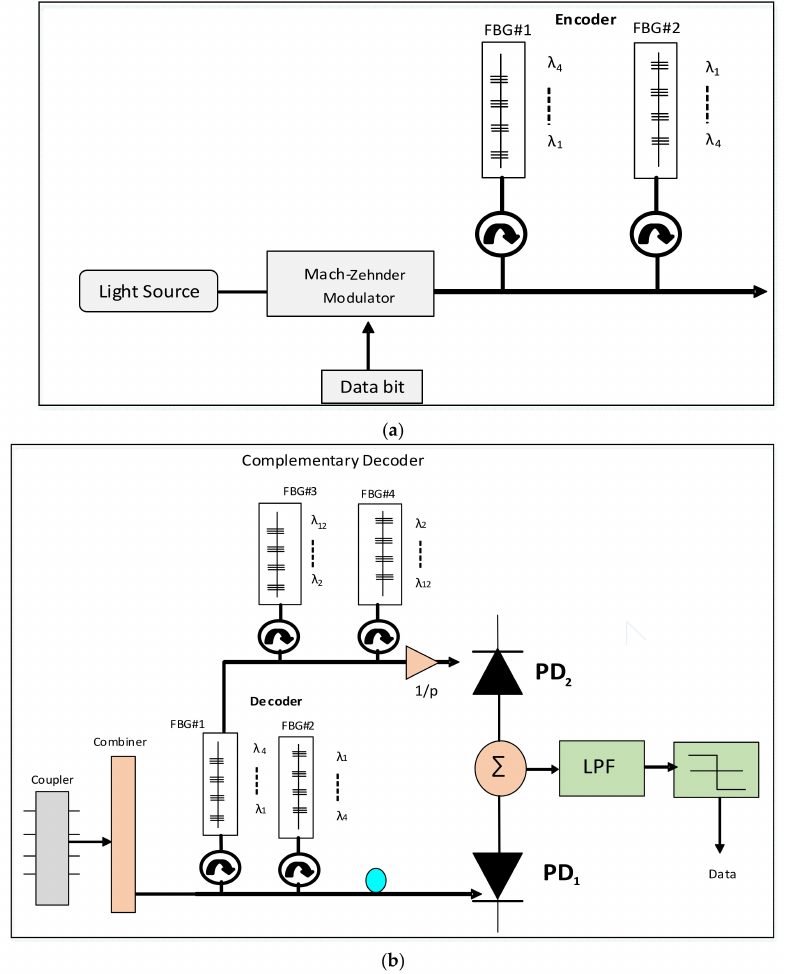
Figure 1. Block diagram implementation of DPS code for P = 3: structure of ( a ) transmitter, ( b )